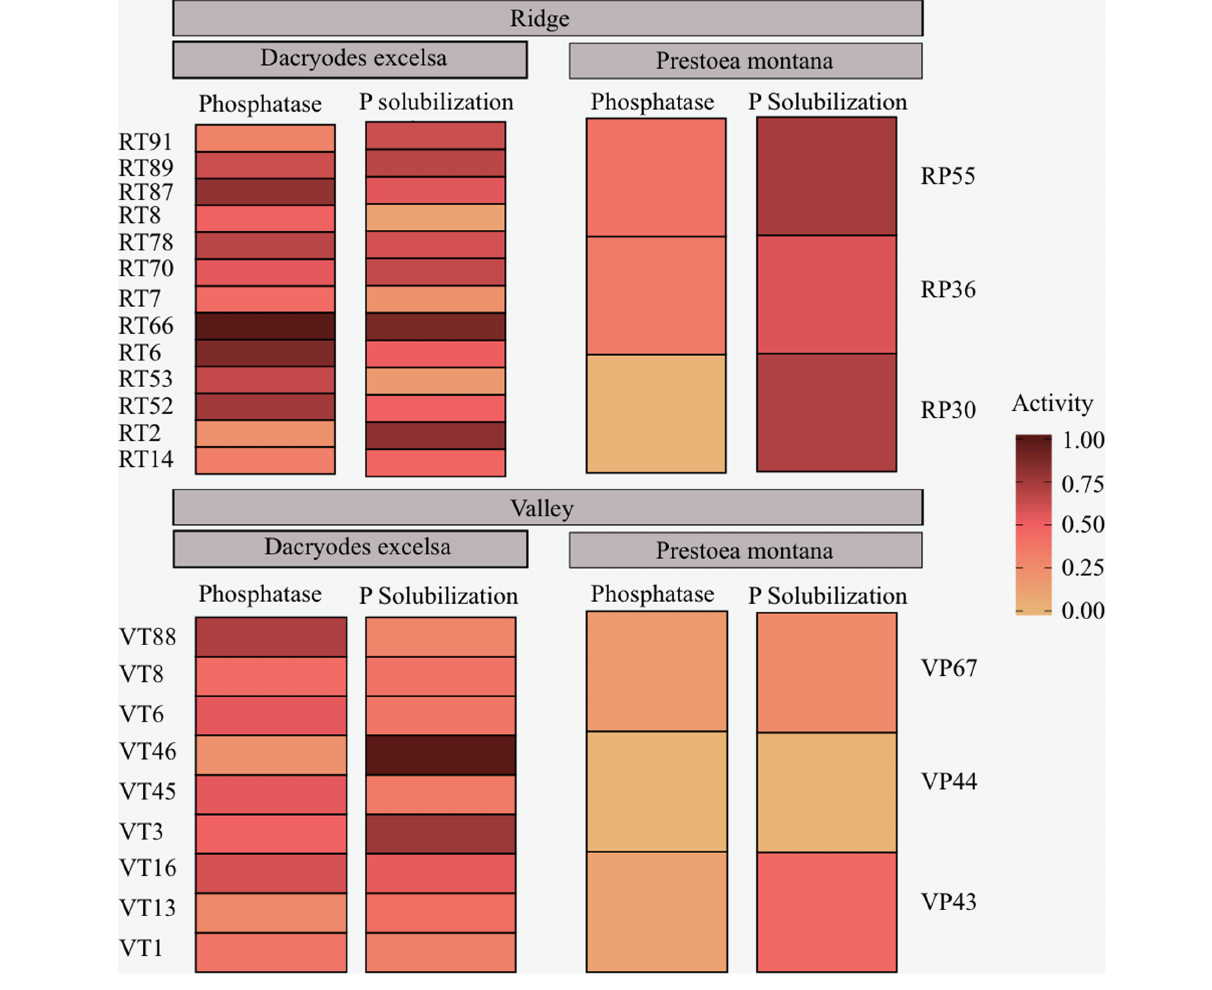
FIGURE 4 | Functional assays of phosphatase activity and P solubilization activity of bacterial isolates from the rhizosphere. Ridge isolates are displayed on top and Valley isolates are on the bottom. Isolates from D. excelsa are on the left and isolates from P. montana are on the